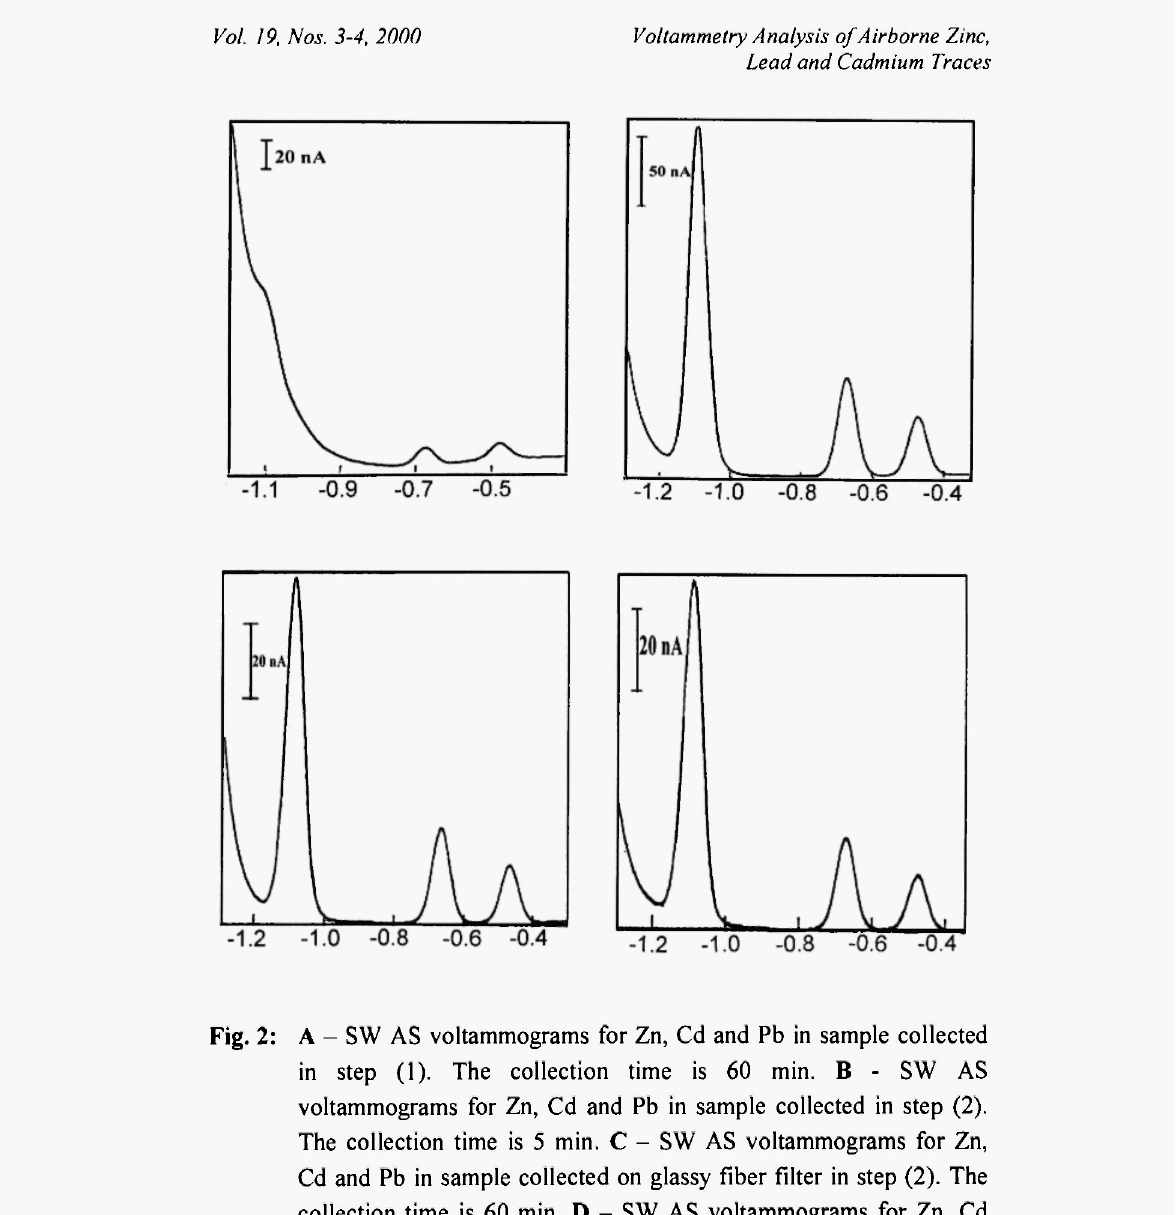
Fig. 2: A - SW AS voltammograms for Zn, Cd and Pb in sample collected in step (1). The collection time is 60 min. Β - SW AS voltammograms for Zn, Cd and Pb in sample collected in step (2). The collection time is 5 min. C - SW AS voltammograms for Zn, Cd and Pb in sample collected on glassy fiber filter in step (2). The collection time is 60 min. D - SW AS voltammograms for Zn, Cd and Pb in sample collected using Venturi-device in step (2). The collection time is 60 min. AS SWV conditions: Deposition time 2 min at -1.25 V vs. Ag/AgCl. Potential scan rate 200